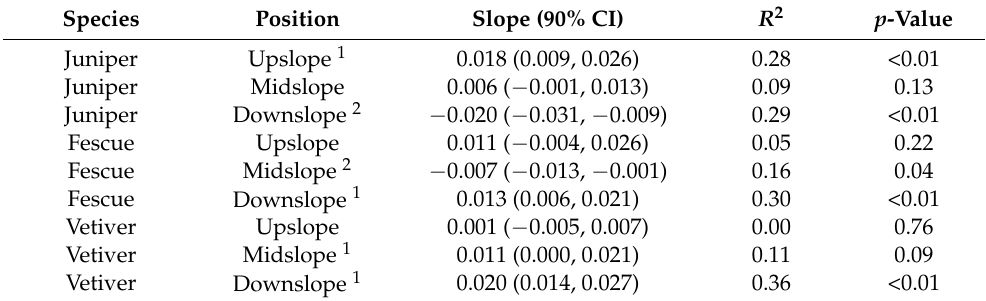
Figure 9. Linear regression for the plot with fescue grass between time in days and erosion pin height relative to the measurement on 12 October 2021, when all erosion pins were installed and stabilized. Solid blue lines and markers show the trajectory of measurements for each erosion pin and dashed red lines show the regression line. Regression slope is given in each plot with * indicating a regression p -value less than 0.1. Regression lines are calculated separately for upslope (top), midslope ( middle ), and downslope ( bottom ). Table 2. Slope of the regression line with 90% confidence interval between time in days and change in erosion pin height in mm and regression statistics for each plot and slope